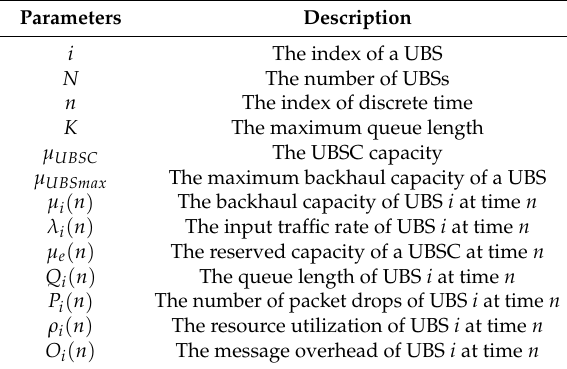
Table 1. Parameters used in the underwater base station initiating (UBSI) resource allocation protocol. UBS: underwater base station; UBSC: underwater base station